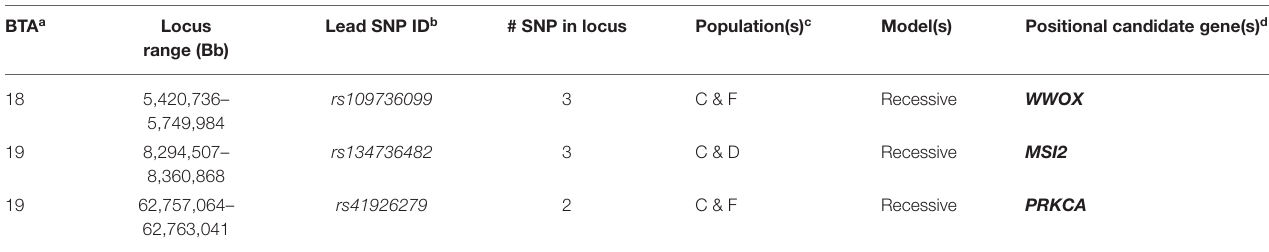
TABLE 1 | Loci associated with bovine coronavirus infection across